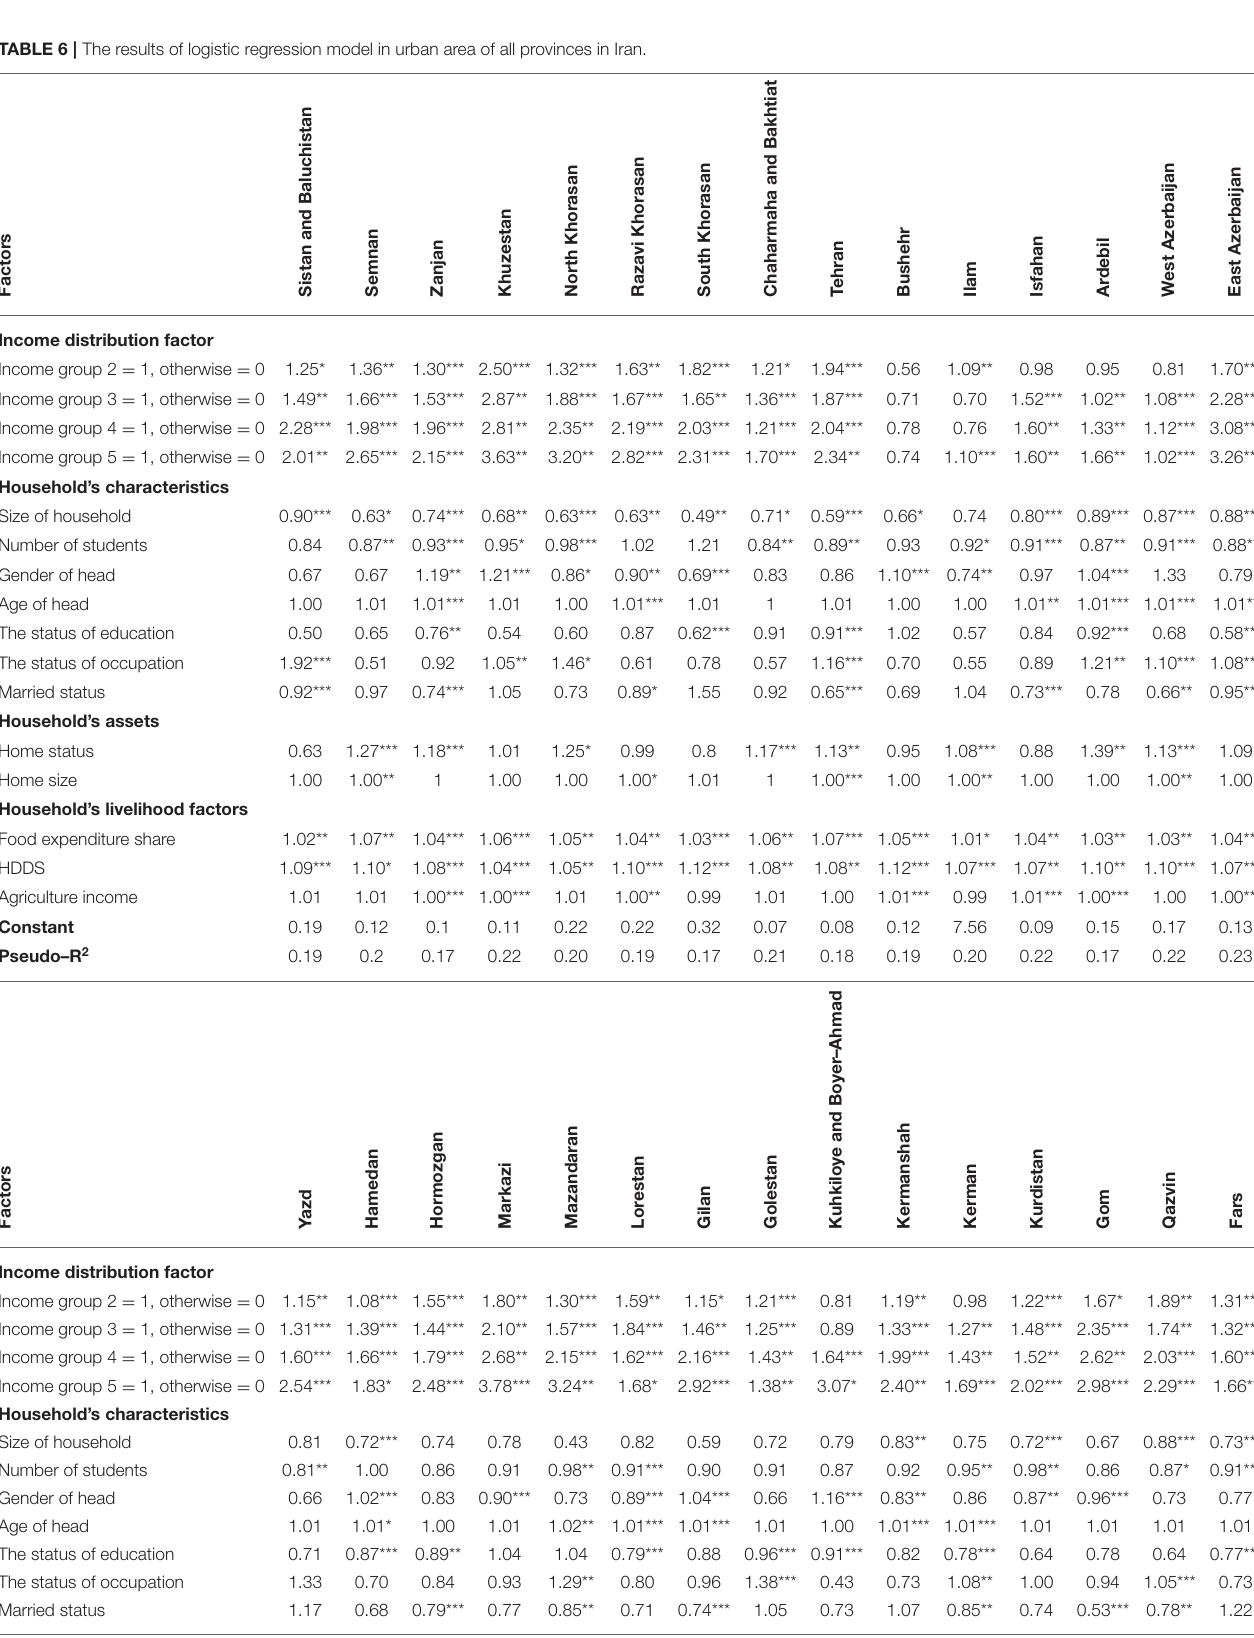
TABLE 6 | The results of logistic regression model in urban area of all provinces in